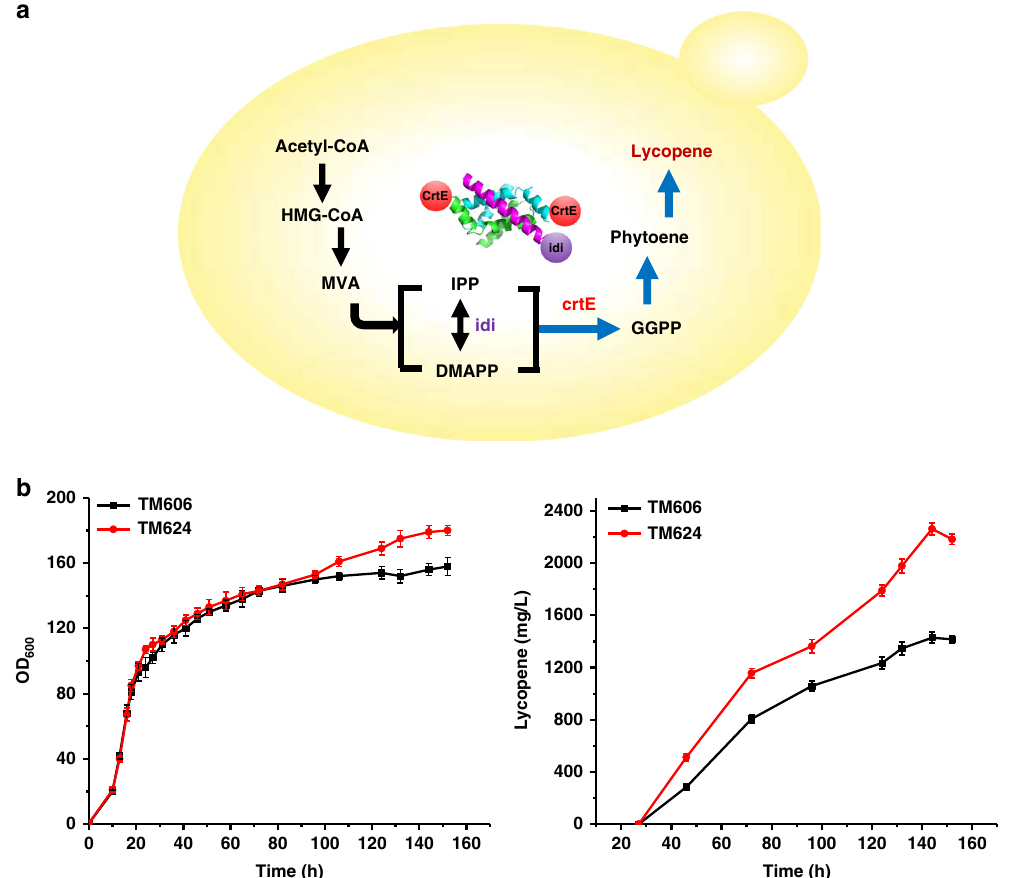
Fig. 5 Idi-CrtE assembly increases lycopene production in yeast in fed-batch fermentation. a A scheme showing that the Idi-CrtE assembly of lycopene biosynthesis in S. cerevisiea . b Enzyme assembly increases lycopene production and the cell mass. Black line: TM606; red line: TM624. Error bars indicate the standard deviations of two replicates. Source data are provided as a Source Data fi